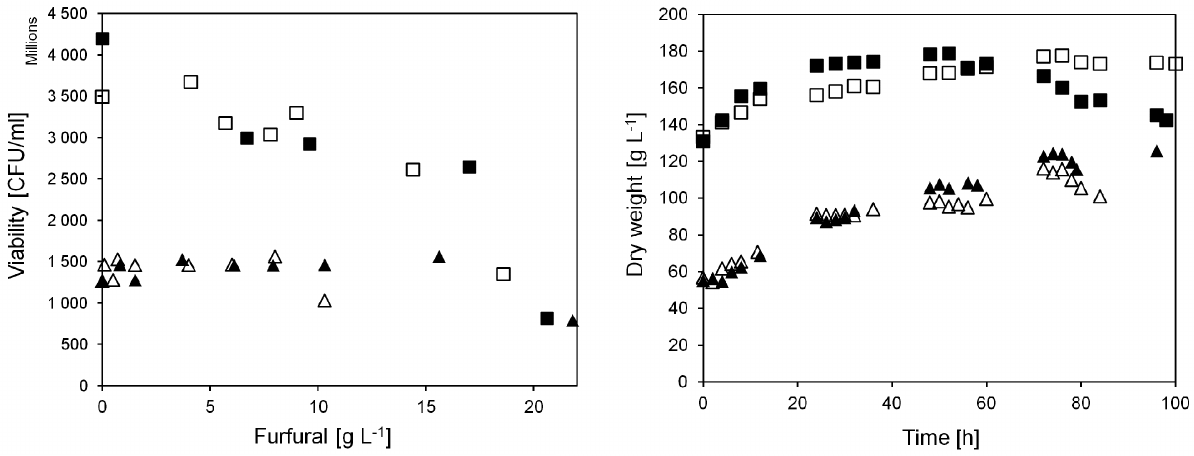
Figure 3. Yeast viability and biomass dry weight at different furfural additions in anaerobic continuous cultivations on sucrose. Triangular symbols denote pulse injection experiments, viability measured 4 h after furfural injection. Square symbols denote experiments with continuous furfural addition, viability measured after 24 h continuous addition of furfural at the indicated concentrations. Closed and open symbols denote cultivation A and B,